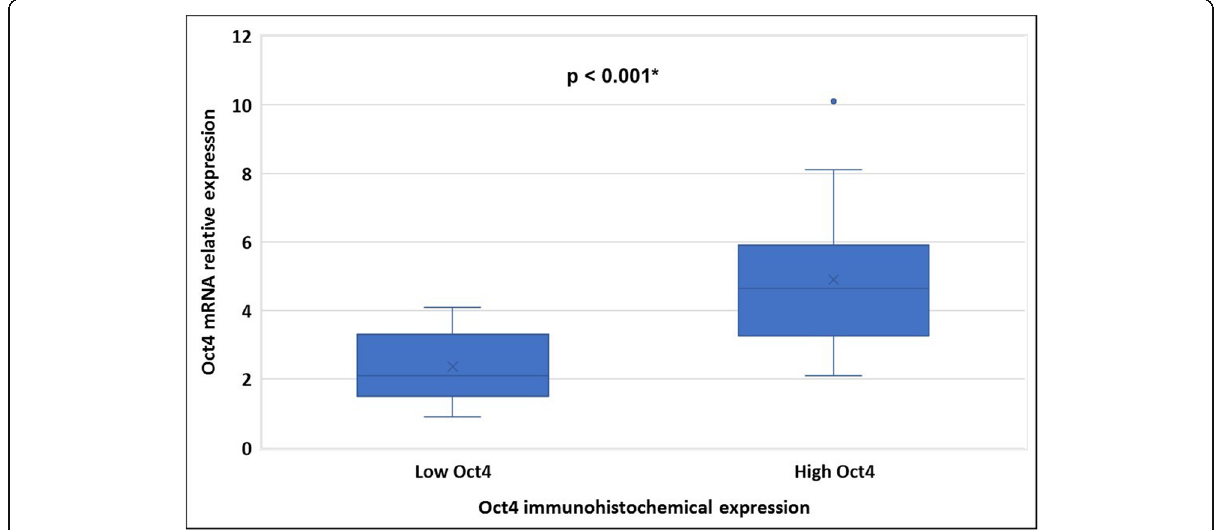
Fig. 6 Relation between Oct4 mRNA relative expression and Oct4 immunohistochemical